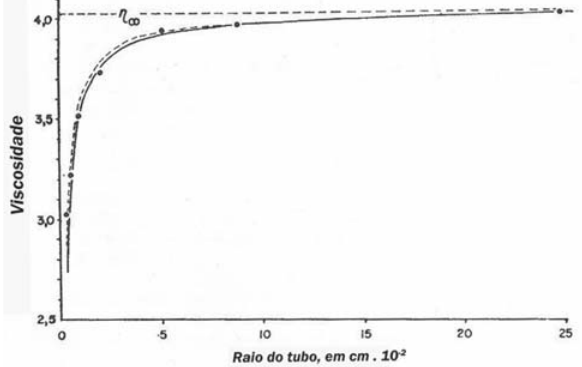
Fig. 5 - O efeito Fahraeus-Lindqvist: a viscosidade do sangue, de hematócrito normal, medida em viscosímetros de vidro de raios variáveis. Para raios maiores que 1 mm, a viscosidade do sangue é constante. Para raios menores, a viscosidade decresce em função do decréscimo do raio. Retirado de Silva Jr MR. Fisiologia da circulação. 2ª ed. São Paulo:Edart;1977.